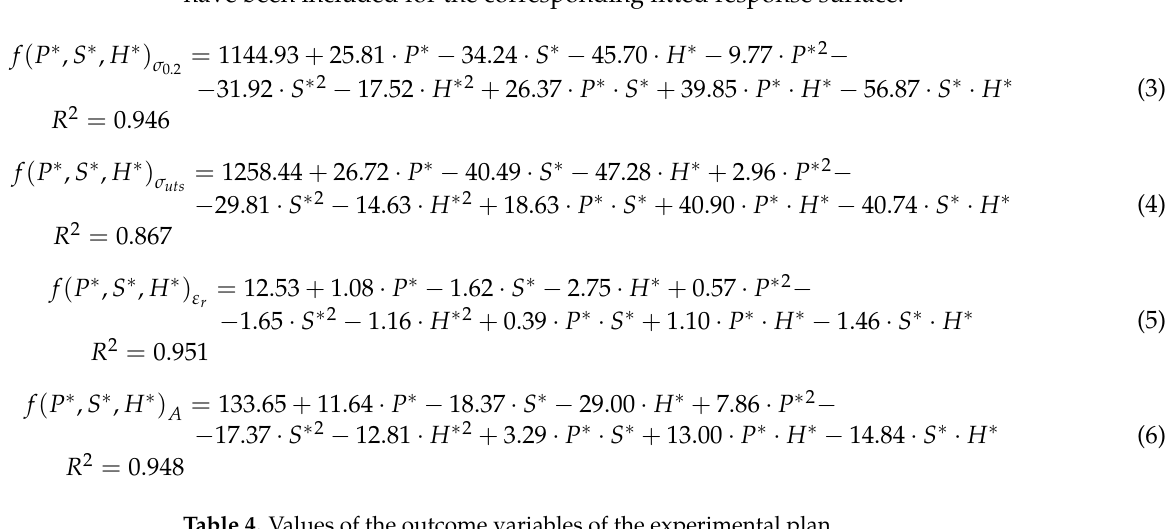
Table 4. Values of the outcome variables of the experimental